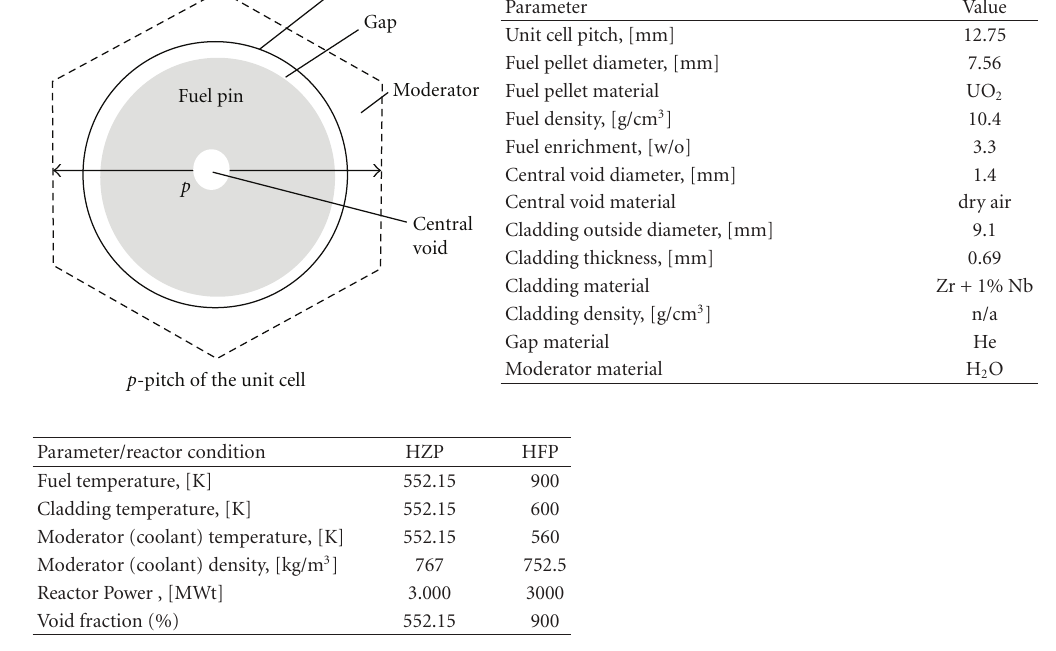
Figure 3: Configuration of Kozloduy-6 VVER-1000 unit cell. Table 2: Manufacturing tolerances for TMI-1 test